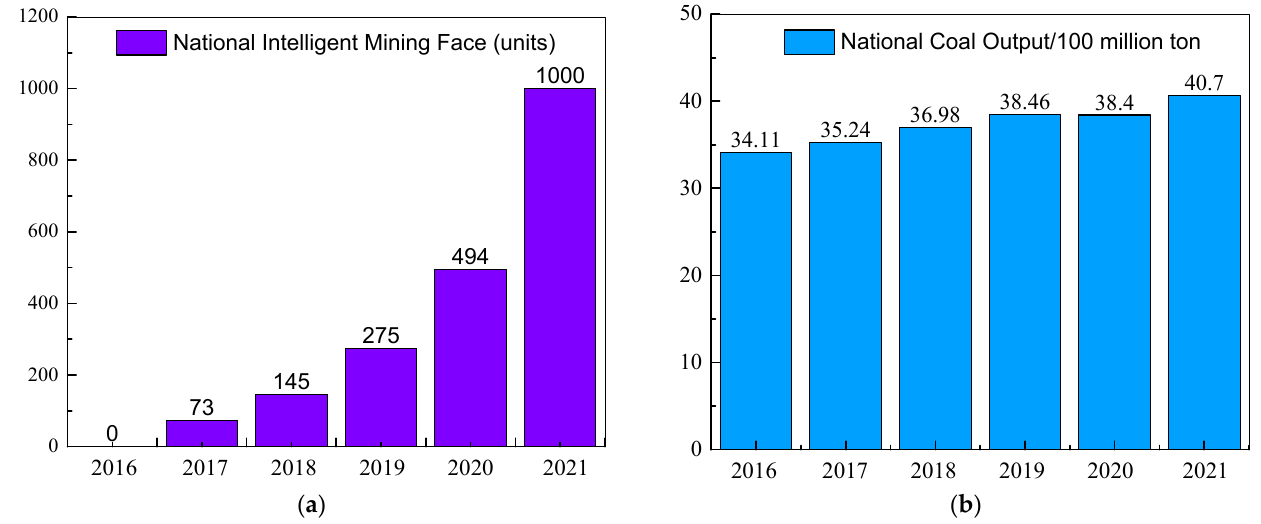
Figure 1. ( a ) Development plan of intelligent working faces; ( b ) Market scale of China’s coal indus-